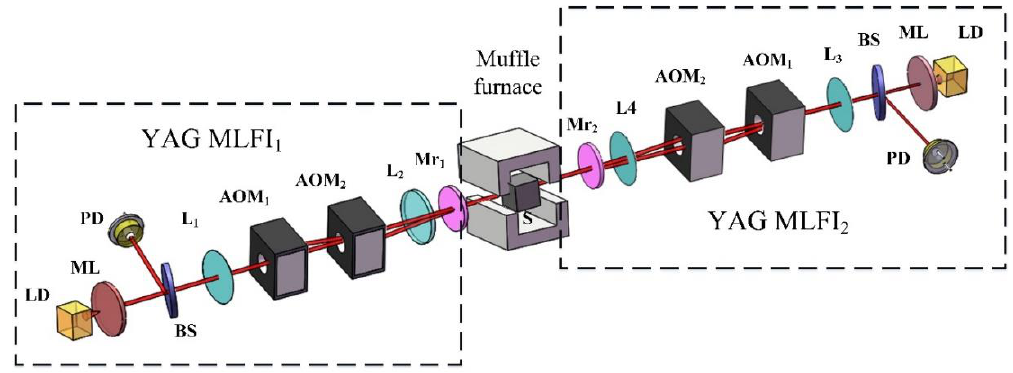
Figure 15. Schematic diagram of the measurement of thermal expansion coefficients based on the YAG MLFIs. YAG MLFI 1 and YAG MLFI 2 , Nd:YAG microchip laser feedback interferometry systems; LD, laser diode; ML, microchip laser; BS, beam splitter; PD, photo detector; AOM 1 and AOM 2 , acousto-optic modulators; L 1 , L 2 , L 3 , and L 4 , lenses; Mr 1 and Mr 2 , reference mirrors; S, sample. (Figure reproduced from Ref. [76]).